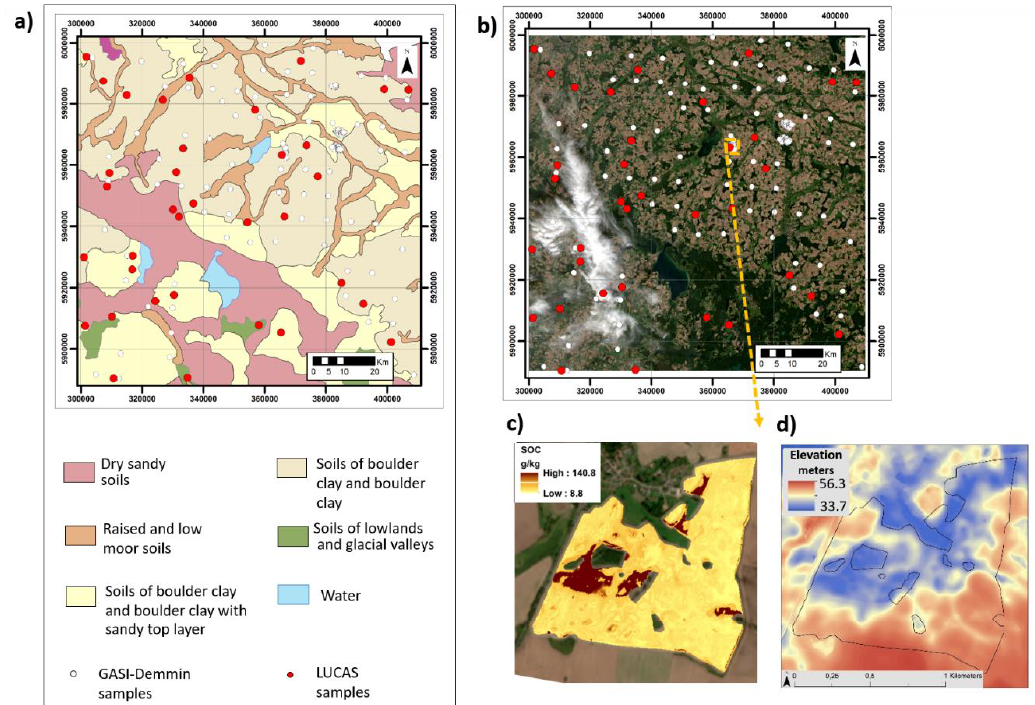
Figure 1. Soil association map ( a ) and RGB (Red: 665 nm, Green: 560 nm, Blue: 490 nm) satellite image ( b ) acquired by Multi-spectral Instrument (MSI) Sentinel-2 sensor. Zoom of the Borentin field illustrating the spatial patterns in SOC ( c ) (modified from Castaldi et al. [6]) and the elevation map obtained from a digital terrain model ( d ). All panels are in the Demmin area (Terrestrial Environmental Observatory Northeast test site) in North-eastern Germany. Coordinates are in WGS 84 / UTM zone 33N.